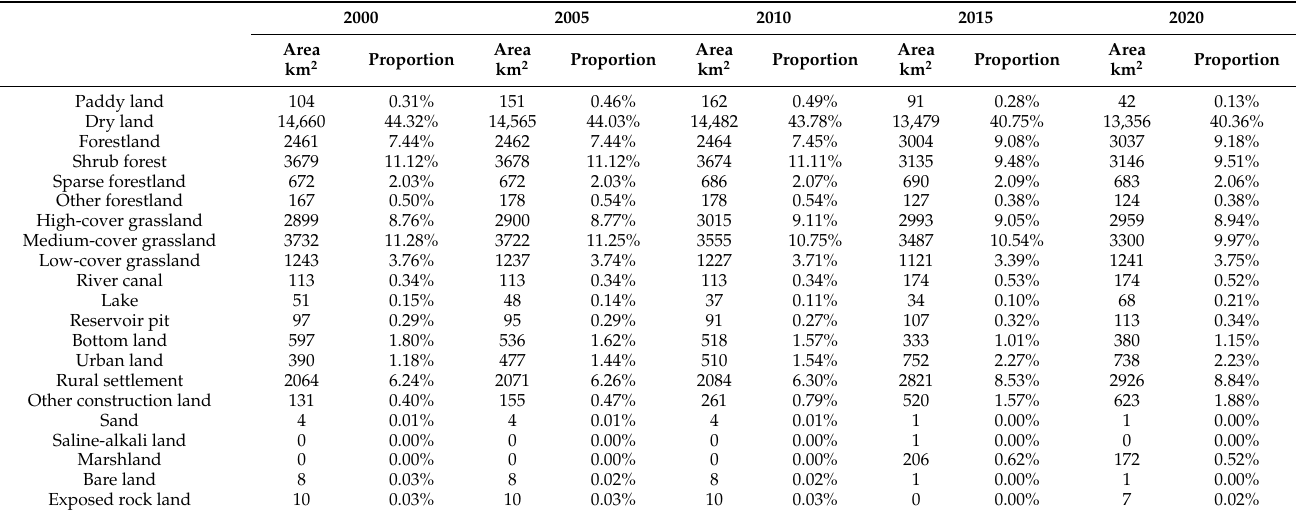
Table 3. Land use patterns in the Baiyangdian basin from 2000 to